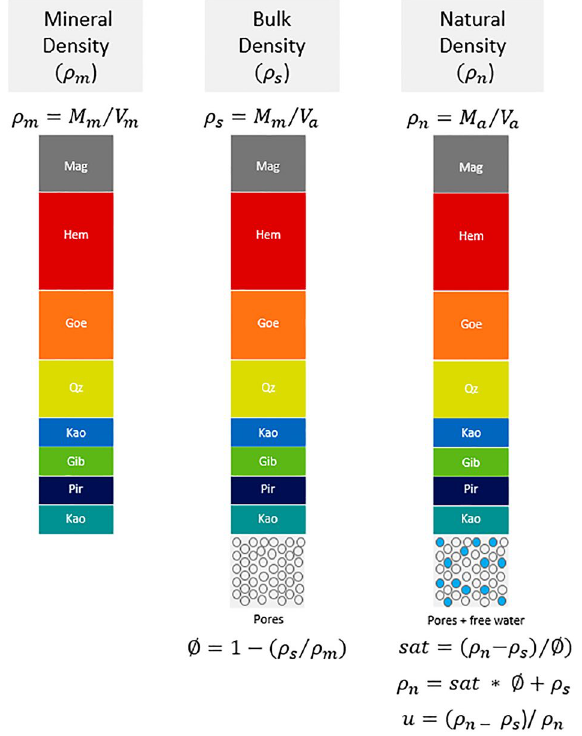
Fig. 4 Relationship among densities, porosity and saturation. Leg- end: ρ = Mineral density; M = Mineral mass; V = Mineral volume; m m m ρ = Bulk density; ρ = Natural density; M = Sample mass; V = Sam- s n a a ple volume; ϕ = Porosity; sat = Saturation; u = Moisture